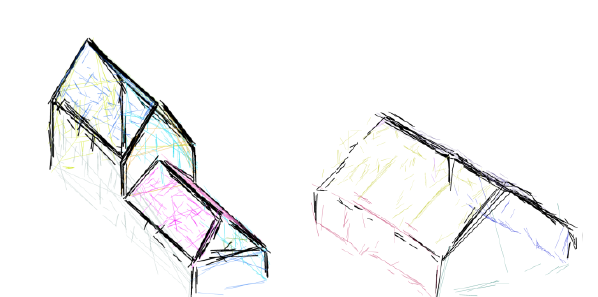
Figure 3. Line segments belonging to different planes are differently colored and line segments belonging to more than one plane are black